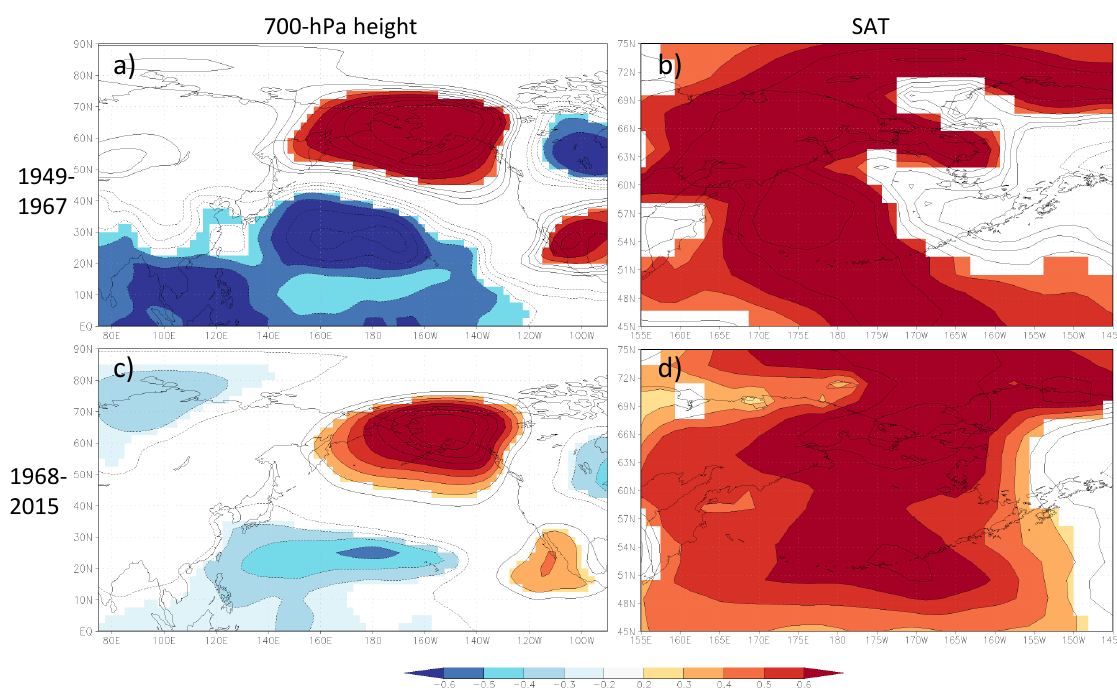
Figure 11. Same as Figure 10, except for Alaskan index and two correlation